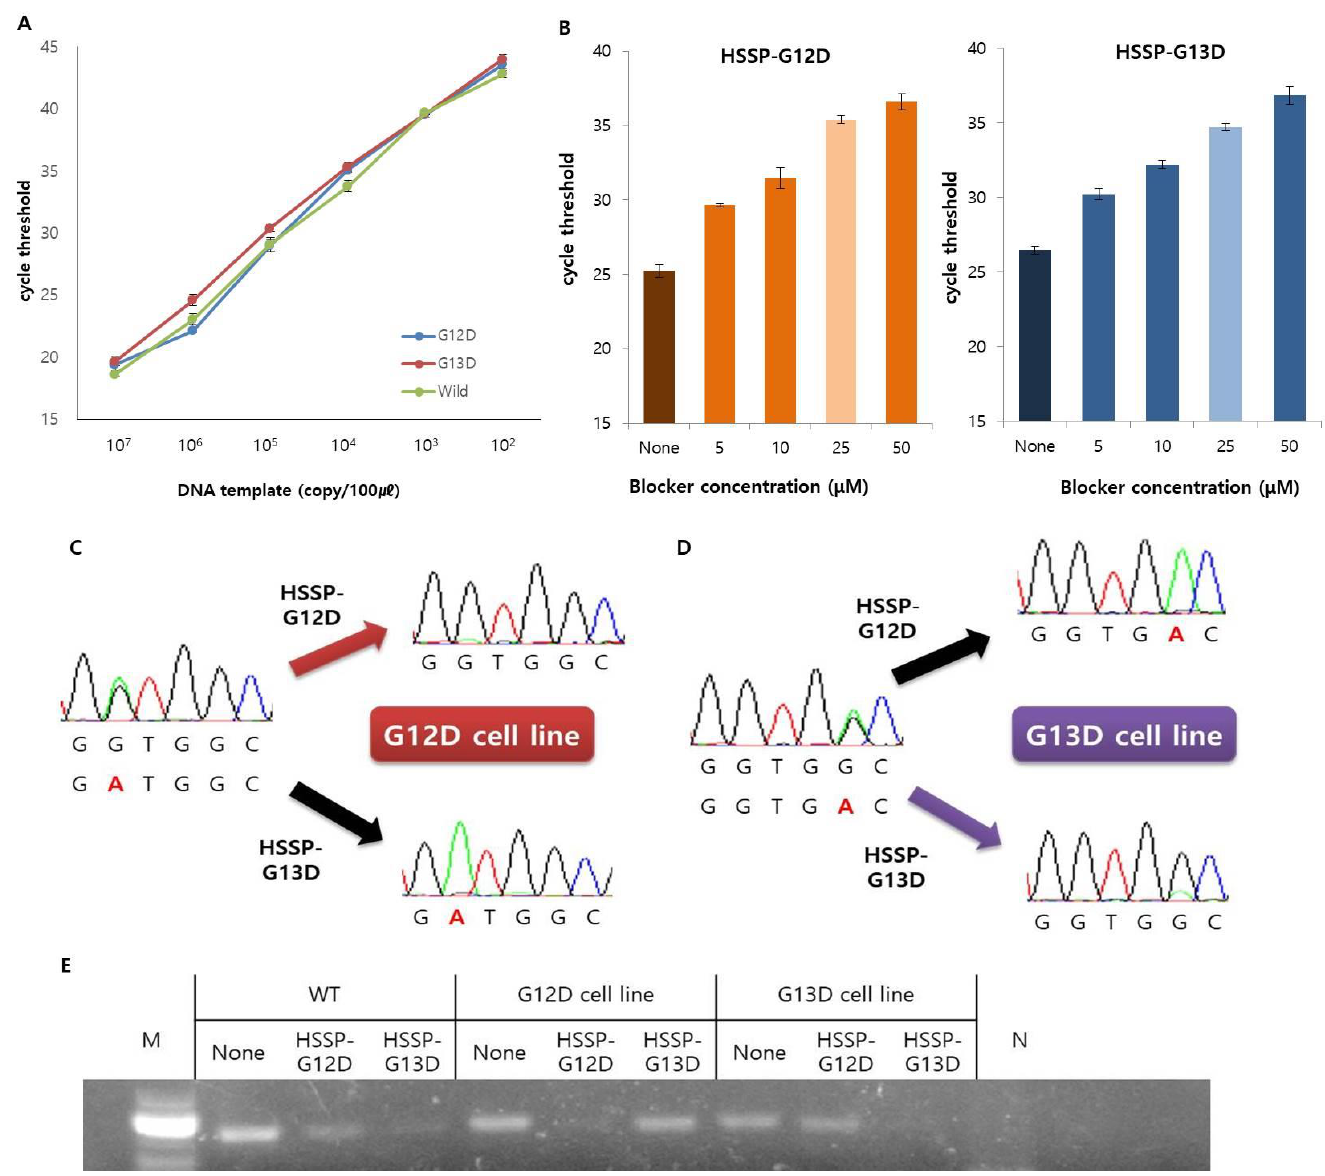
Figure 2. Optimization and application of the KRAS mutations primer and HSSP. ( A ) Serial dilution of DNA template was used to test the detection limit of the PCR primer. In the same way, up to 10 2 copies can be detected in three types. Data are presented as mean ± SD, based on at least three independent experiments. ( B ) Efficiency of the HSSP depends on the concentration. It showed the largest difference at the highest concentration and the most stable value at 25 µM. This is marked in light colors. Controls without HSSP are displayed in deeper colors. Data are presented as mean ± SD, based on at least three independent experiments. ( C – E ) Operation of the HSSP was confirmed from direct sequencing and electrophoresis after end-point PCR. This shows that mutations were not amplified in DNA with the same sequence as the HSSP. ( C , D ) These render direct sequencing results to confirm the operation of the HSSP on ( C ) G12D cell line and ( D ) G13D cell line. ( E ) Electrophoresis results after end-point PCR confirmed the operation of the